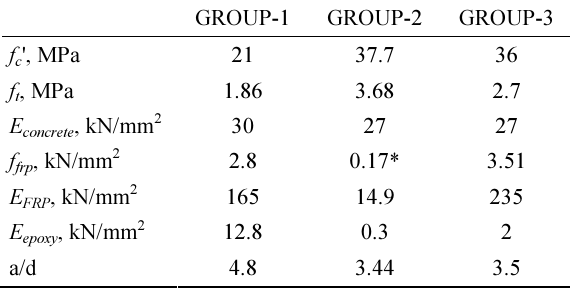
Fig. 1. Geometrical dimensions of experimental beams ø Table 1. Material properties of test groups